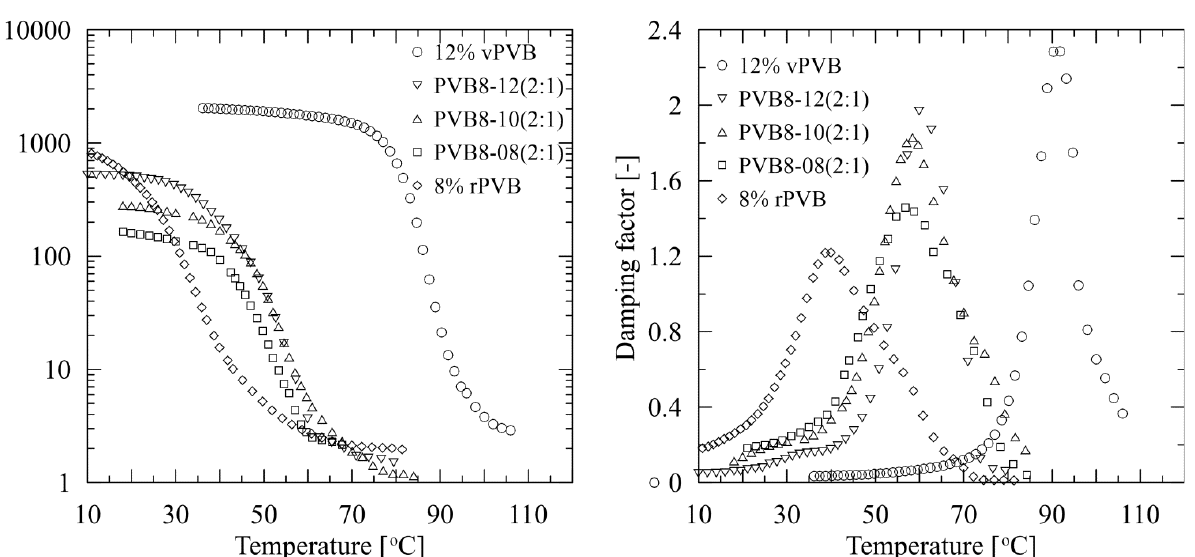
Table 6. Evaluation of T g from DMA measurements for rPVB and blended PVB nonwoven nano-